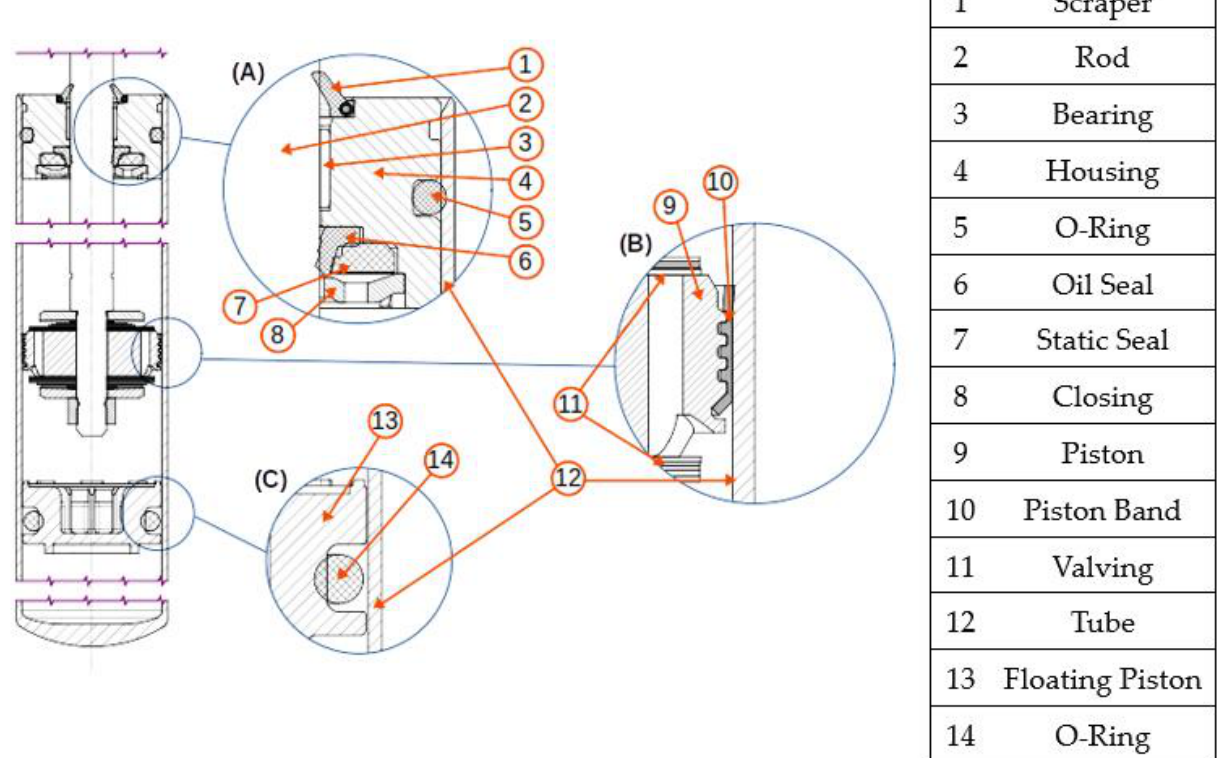
Figure 1. Reference damper overview with details of the single friction points ( A ) rod guide assembly/rod; ( B ) piston/tube; ( C ) floating piston/tube.